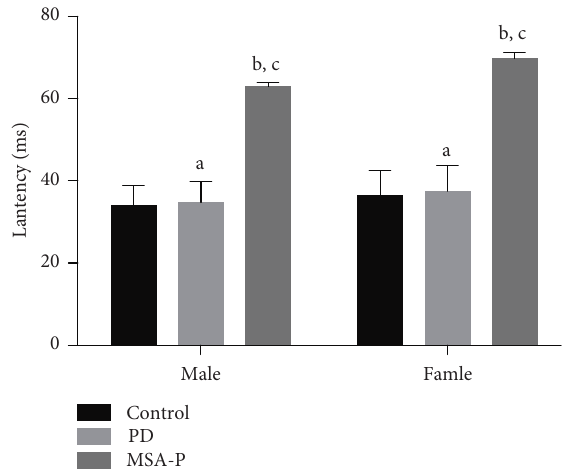
Figure 2: Comparison of BCR latency in the Parkinson’s disease group, MSA-P group, and healthy control group. a p > 0 . 05 compared to control. b p < 0 . 05 compared to control. c p < 0 . 05 compared to